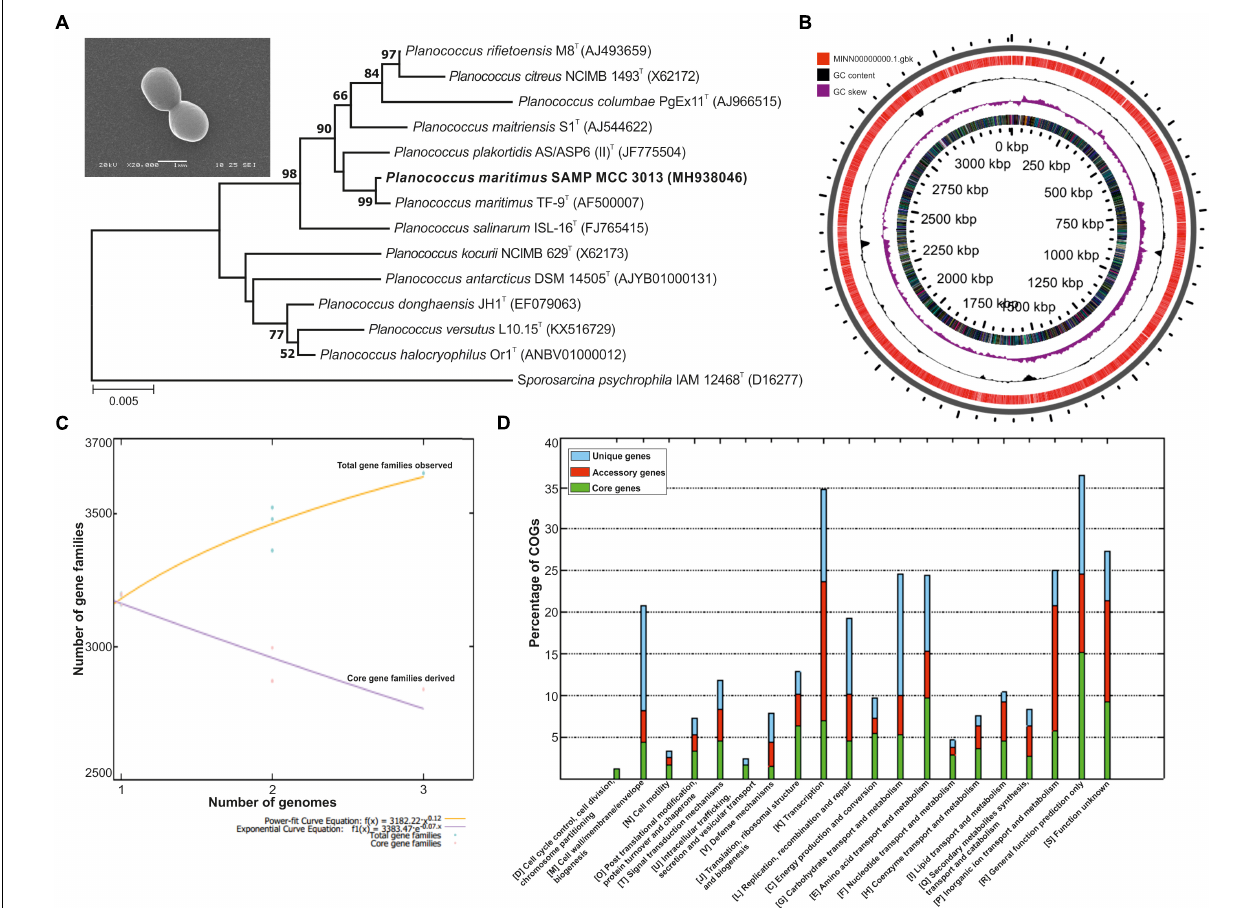
FIGURE 1 | (A) Phylogenetic tree reconstructed by a neighbor-joining analysis based on 16S rRNA gene sequences, depicting the phylogenetic relationship of strain SAMP to related type strains of the genus Planococcus Bar, 0.005 changes per nucleotide position. Bootstrap values (%) > 50% from 1,000 replicates are shown and inset showing scanning electron micrograph (SEM) of P. maritimus SAMP MCC 3013. (B) Circular genome plots. The outermost concentric circles denote the predicted protein-coding genes present in both forward strand and the reverse strand. The next concentric represents the GC content and the purple color show the GC content below average. (C) The numbers of shared genes were plotted as a function of number of strains. (D) COG distribution in core, accessory and unique